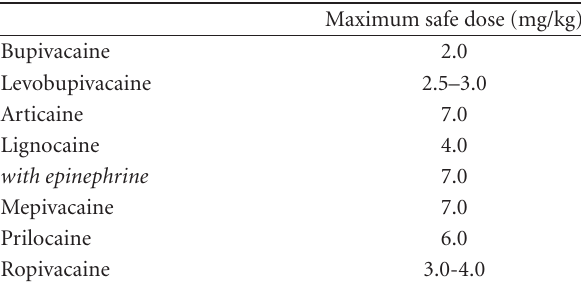
Table 3: Safe doses of common